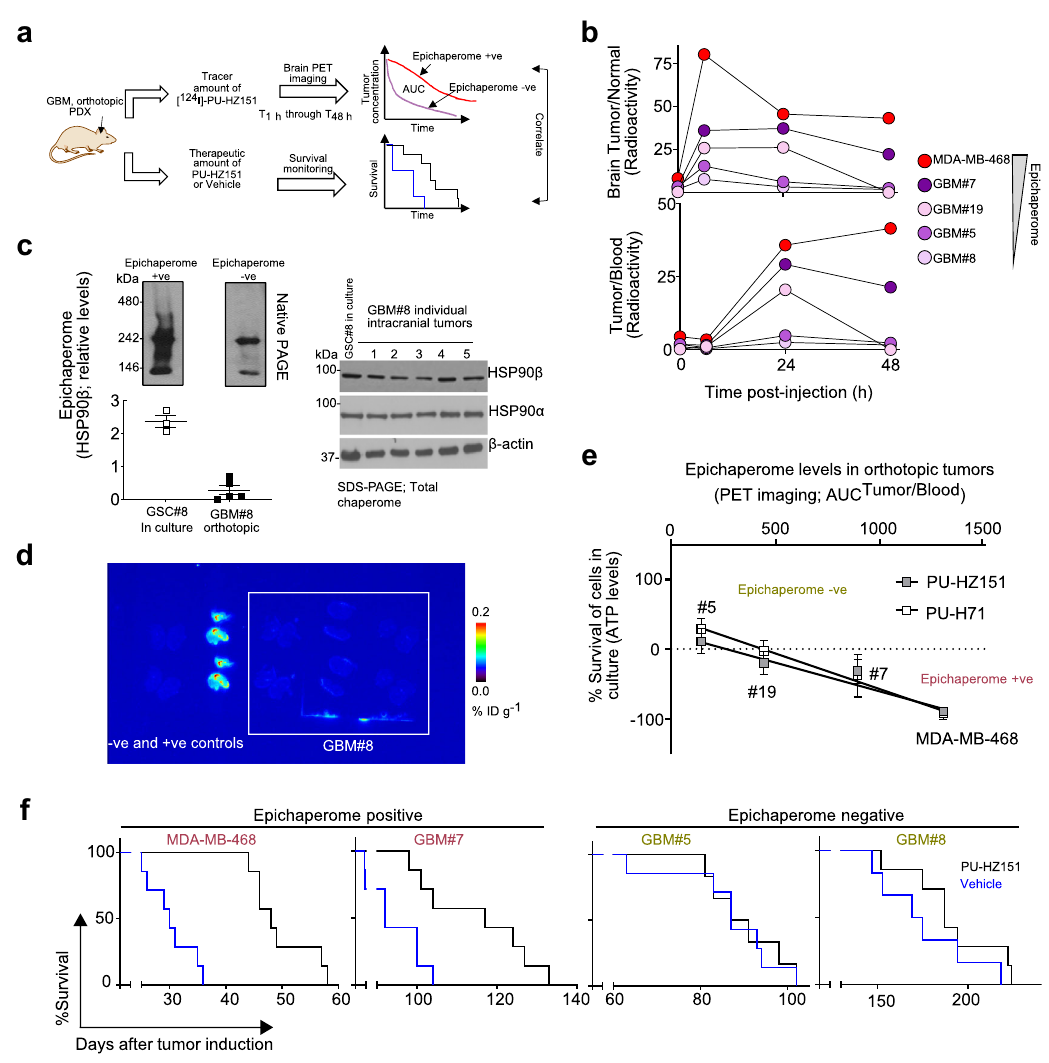
Fig. 7 PET imaging with [ 124 I]-PU-HZ151 detects and quanti fi es epichaperome-positivity. a Schematic of the experimental design. PDX patient-derived xenograft. b PET determined time-dependent concentration of [ 124 I]-PU-HZ151 in intracranial tumors, in the surrounding, unaffected brain, and in the plasma. Serial PET/CT images were obtained at the times indicated after single intravenous infusion of a microdose of [ 124 I]-PU-HZ151 (15 µ Ci g − 1 ). Data are plotted as ratio of the recorded PET signals. n = 5 mice per tumor type. c Epichaperome quanti fi cation in the GBM#8 tumors ( n = 5) from ( b ) compared to levels recorded in cultured GSC#8 cells ( n = 3 cultures). Data are presented as mean ± s.e.m. Representative Native PAGE immunoblotted for HSP90 in epichaperomes and Western blot analyses of total HSP90 levels are also shown. See also Supplementary Fig. 20. d [ 131 I]-PU-HZ151 autoradiography of individual GBM#8 PDX tumors ( n = 3), 4 explants per PDX, as in c con fi rms loss of epichaperome positivity in GBM#8 upon xenotransplantation. e Correlative analysis between GSC cytotoxicity to PU-HZ151 and PU-H71, evaluated as in Fig. 6, and epichaperome levels, evaluated by [ 124 I]-PU-HZ151 PET. Pearson ’ s r , two-tailed, n = 4 tumor types, as indicated. f Kaplan – Meyer survival curves for mice bearing the indicated intracranial tumors. Vehicle, blue curve; PU-HZ151 (50 mg kg − 1 ), black curve. n = 7 mice per condition. Source data are provided as a Source Data fi